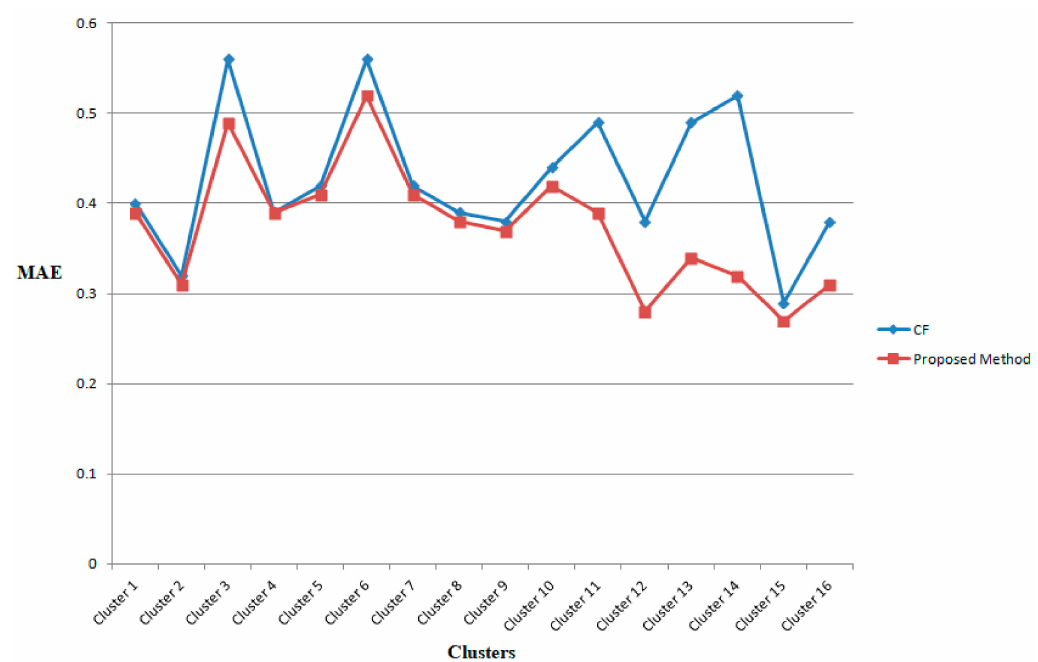
Figure 8. Performance metric comparisons—mean absolute error (MAE).